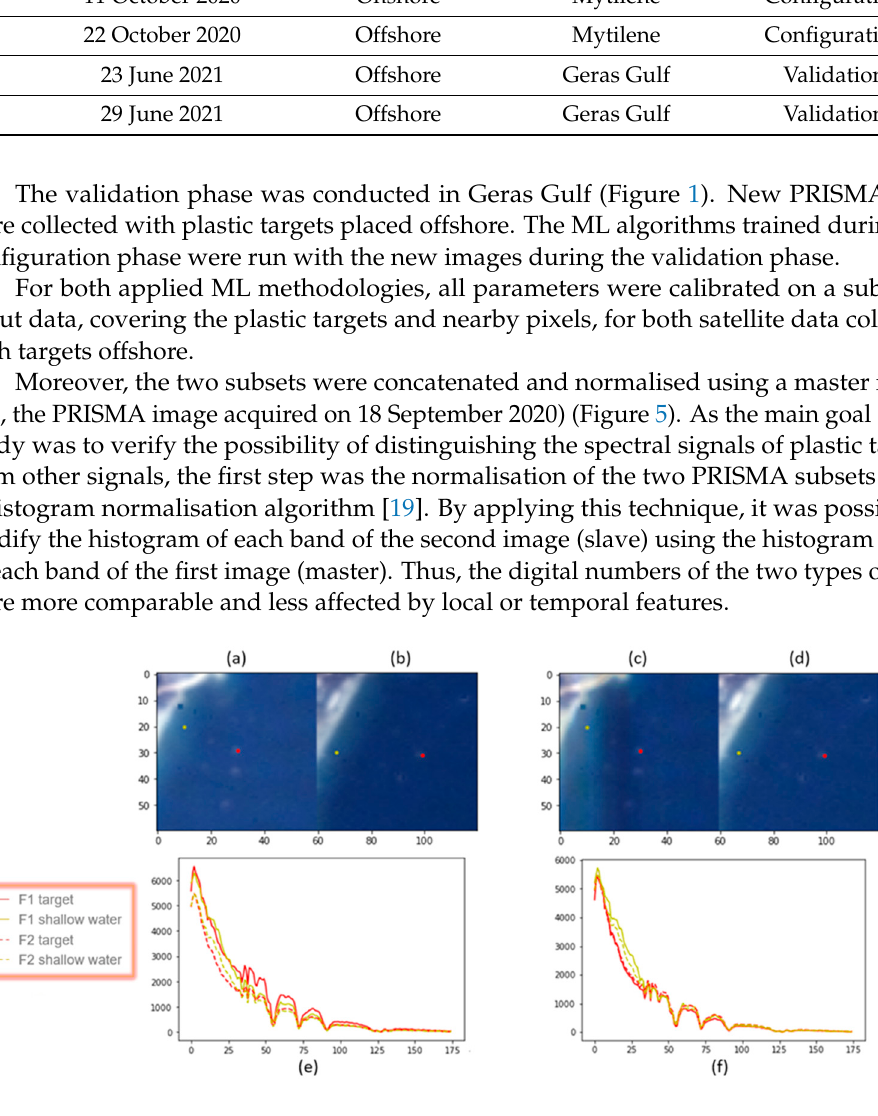
Figure 5. ( a , b ) are the Red–Green–Blue (RGB) representation of satellite data before histogram normalisation: a pixel of the plastic target is highlighted in red, a pixel of shallow water is highlighted in yellow. ( c , d ) are the RGB representation of satellite data after histogram normalisation. ( e , f ) show how the spectral behaviour changed after the normalisation